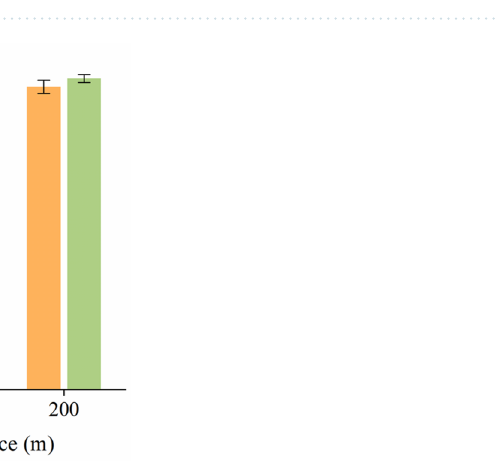
Figure 8. Relationship between the corrected data curve of geoelectric field and the surrounding rock formation of the roadway. ( a )–( d ) self-potential data; ( e )–( h ) excitation current data.